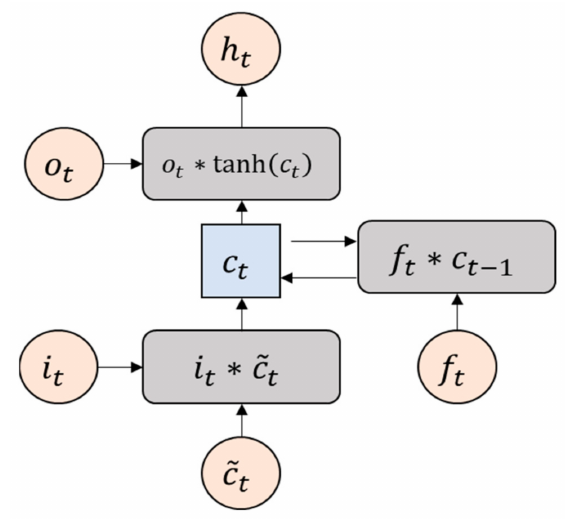
Figure 2. LSTM model